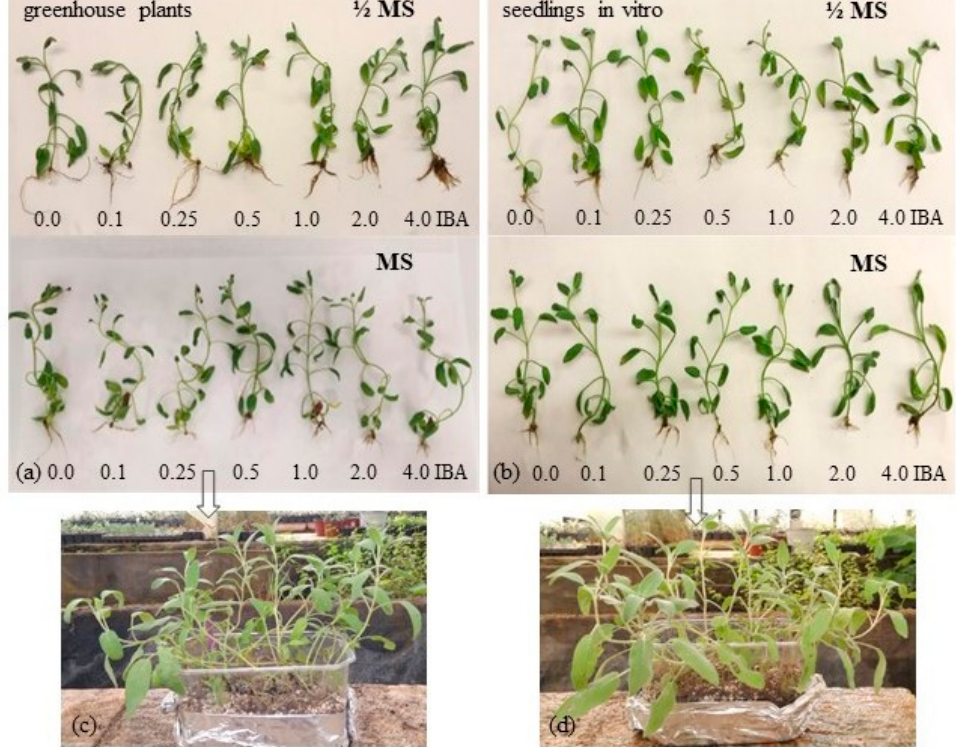
Figure 2. Typical rooting response of S. tomentosa microshoots originated from greenhouse adult plants ( a ) and in vitro seedlings ( b ), in either half- or full-strength MS medium supplemented with 0.0 to 4.0 mg L − 1 IBA; one-month old plantlets originated from either greenhouse adult plants ( c ) or in vitro seedlings ( d ) acclimatized ex vitro.